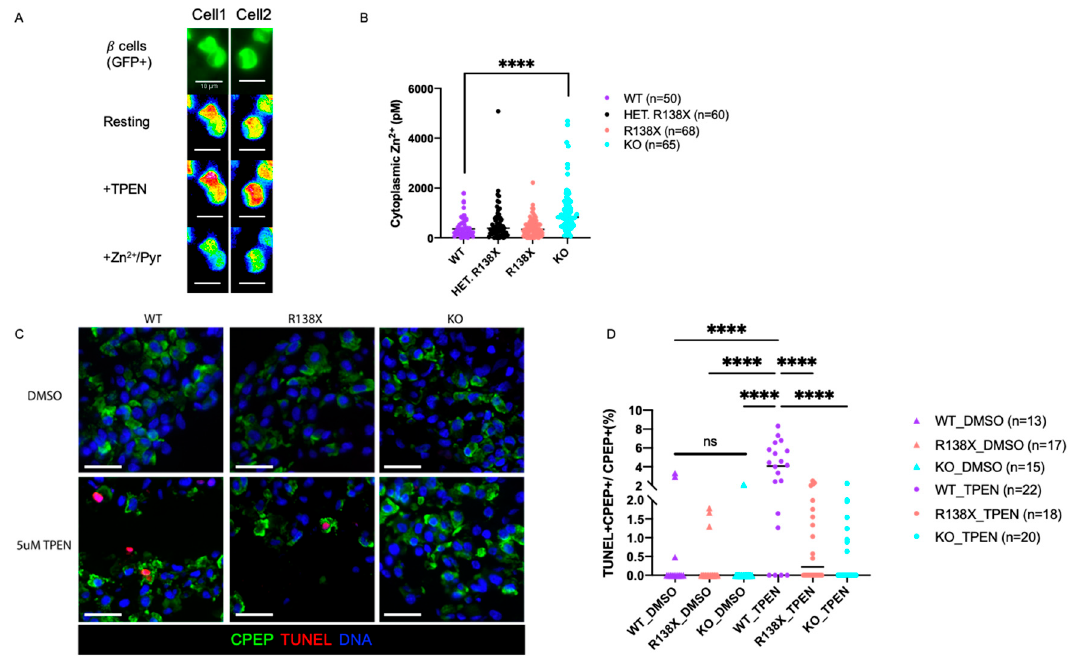
Figure 5. SLC30A8 mutant sc-beta cells are more resistant to low zinc condition and upregulated cy- tosolic free Zn 2+ . ( A ) Two representative images (Cell 1 and Cell 2) for cytoplasmic zinc measurement in dispersed insulin GFP-positive cells (maximum ratio upon 5 µ M TPEN (zinc chelator) addition and minimum ratio upon Zn 2+ /Pyrithione (zinc ionophore) (Scale bar: 10 µ m). ( B ) Zinc concentrations measured in insulin GFP-positive cells from 4 independent replicates: WT ( n = 50), HET (R138X heterozygous) ( n = 60), R138X (R138X homozygous) ( n = 68), and KO ( n = 65). ( C ) Representative immunostaining of sc-derived cells from WT, KO, R138X with 48 h of DMSO and 5 µ M TPEN treatment for C-peptide, TUNEL, and Hoechest. (Scale bar: 20 µ m) ( D ) Quantification of TUNEL, C-peptide double positive cells out of total C-peptide positive cells (%) among WT, R138X, and KO lines. One-way ANOVA, p **** < 0.0001 for the indicated